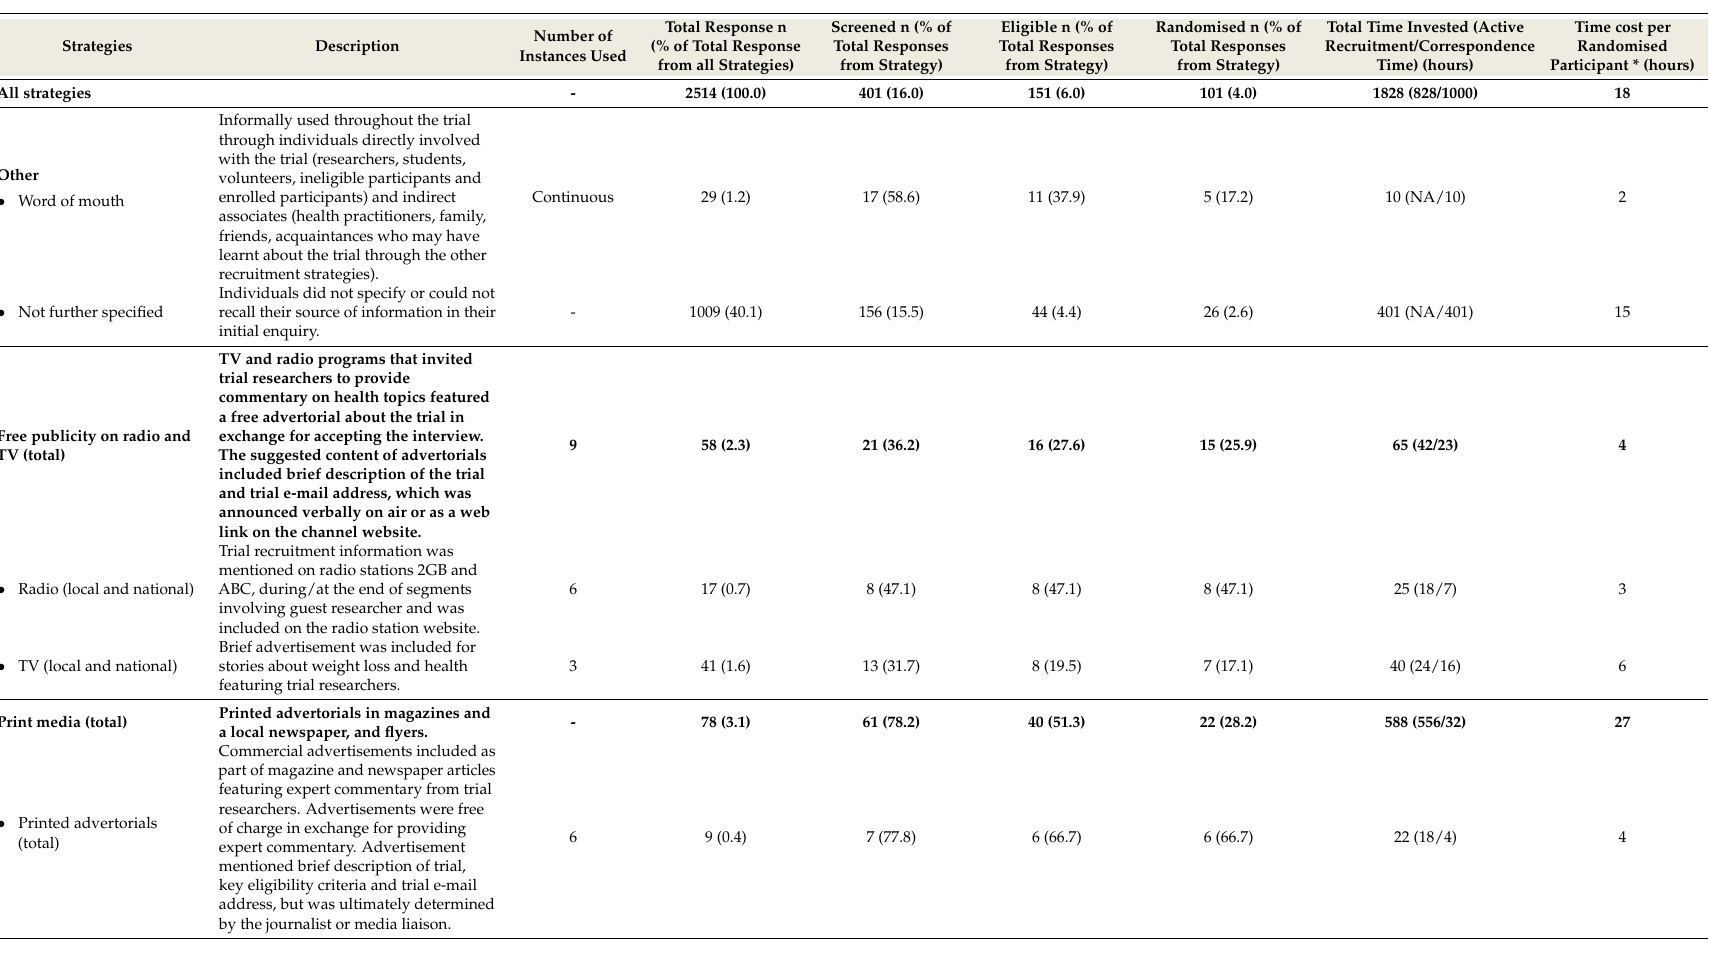
Table 2. Relative effectiveness of recruitment strategies used in the TEMPO Diet